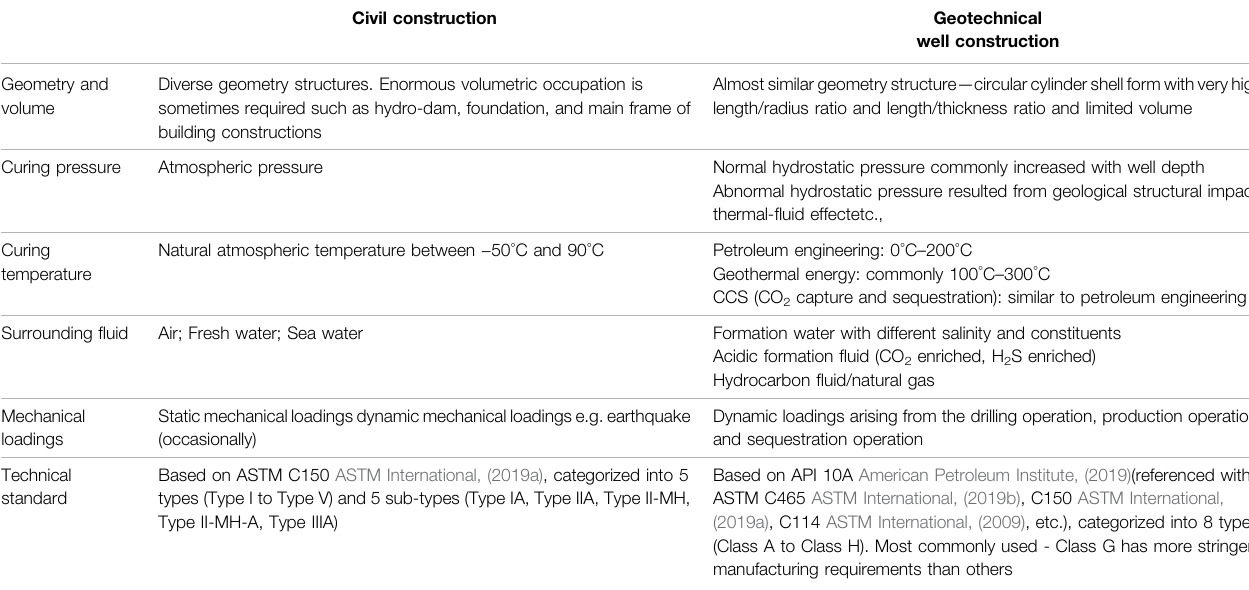
TABLE 1 | Cement material application conditions